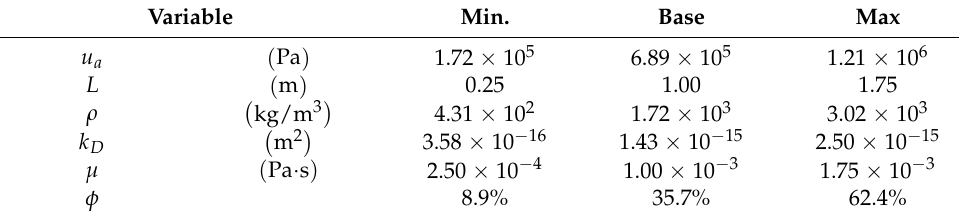
and length of the system. All the other soil and fl uid properties do not a ff ect the transient